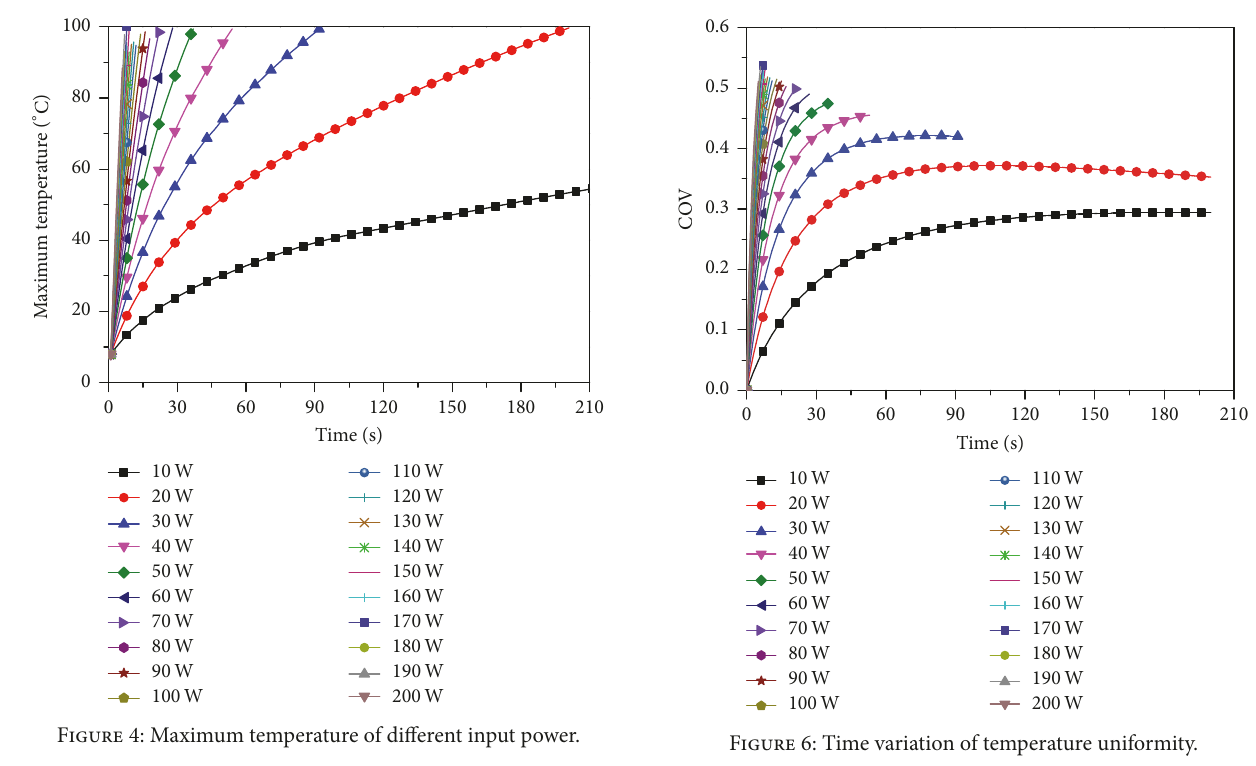
Figure 6: Time variation of temperature uniformity.